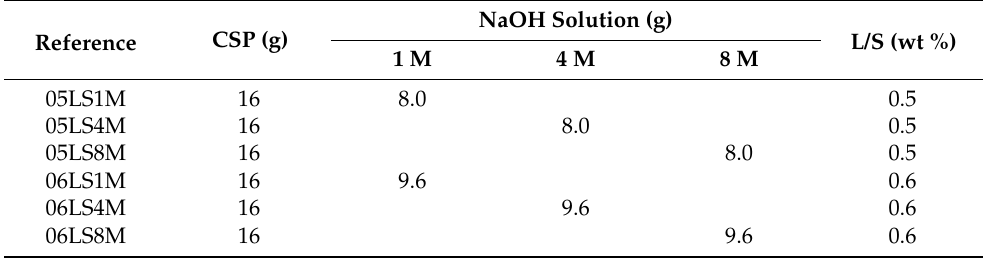
Table 1. The AAC mixture composition.